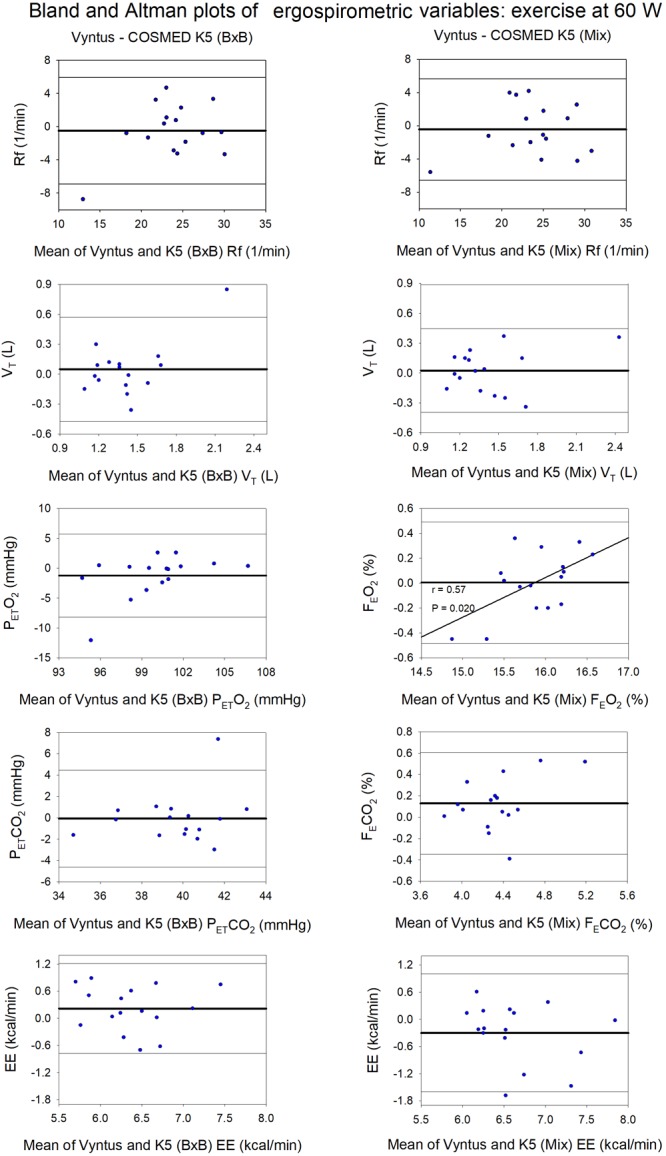
Agreement between Vyntus (used as a reference stationary metabolic cart) and COSMED K5 operated Breath-by-Breath (B×B) and in Mixing Chamber (Mix) modes during low-intensity exercise for respiratory frequency (Rf), tidal volume (VT), end-tidal O2 pressure (PETO2), expiratory O2 fraction (FEO2), end-tidal CO2 pressure (PETCO2), expiratory CO2 fraction (FECO2), and energy expenditure (EE). N = 16.